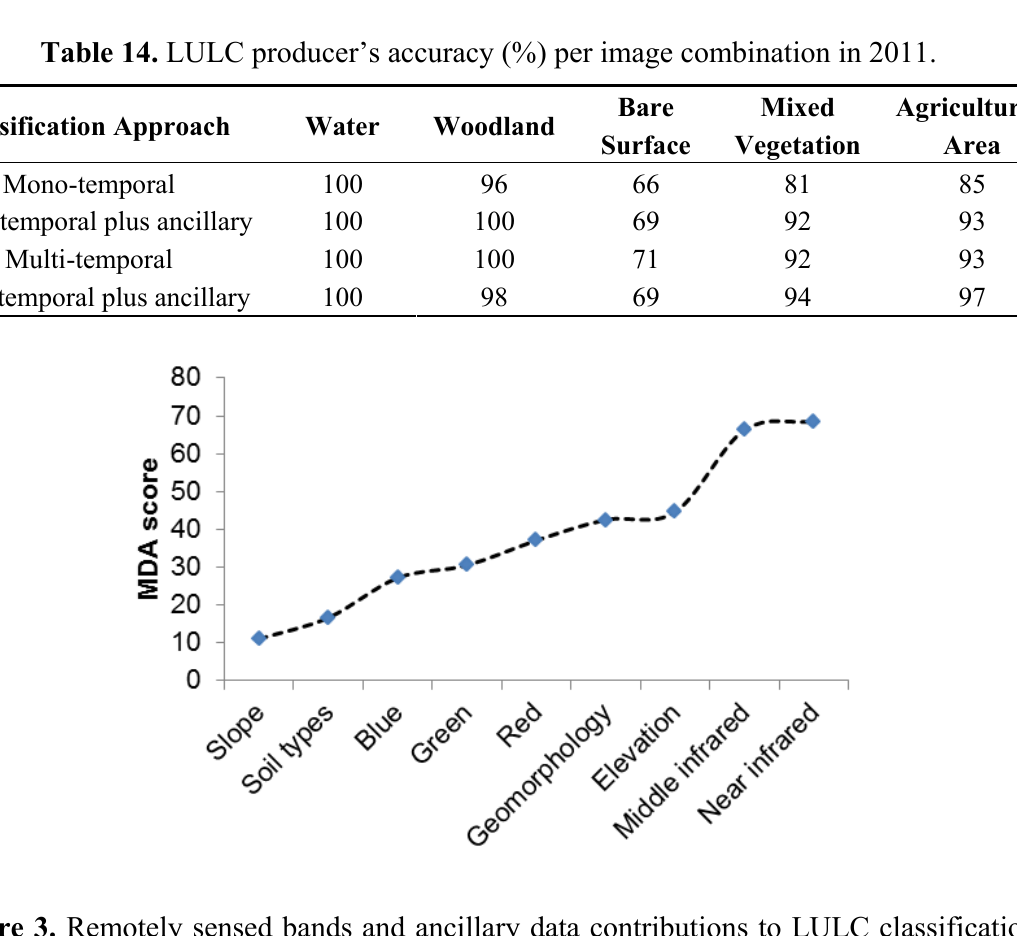
Figure 3. Remotely sensed bands and ancillary data contributions to LULC classification based on mean decrease accuracy (MDA) score of RF mono-temporal image plus ancillary data